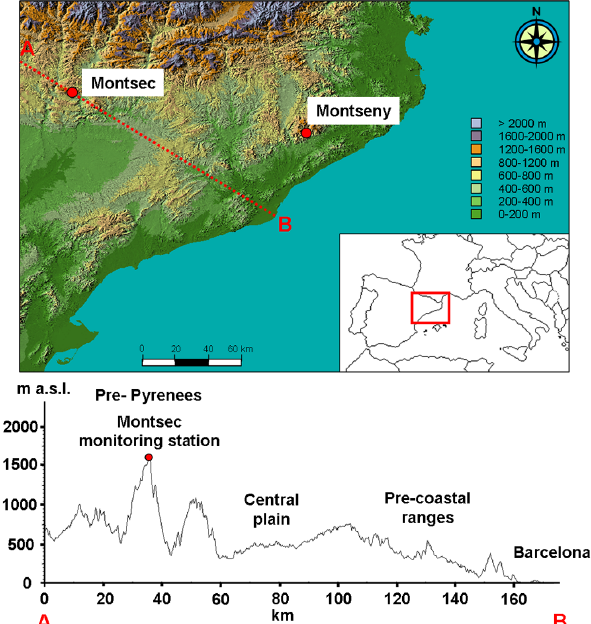
Fig. 1. Top: location of the two monitoring stations (Montsec and Montseny). Bottom: topography of the Montsec area following the red